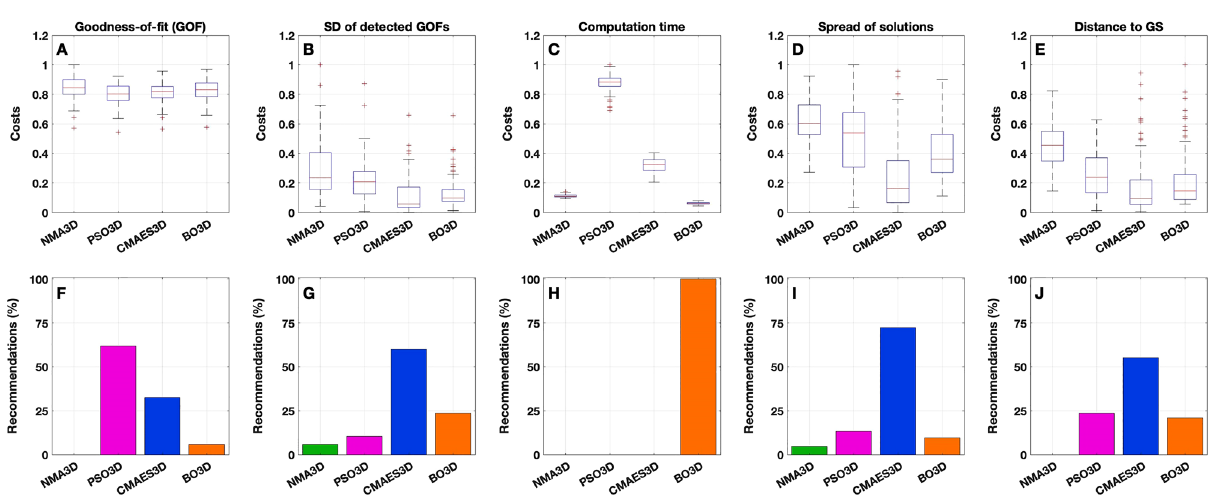
Figure 7. Components of the cost function (cid:31) cost for the 3Dim case. As in Fig. 6, ( A – E ) boxplots illustrate the distributions of the values (normalized by the respective maxima) of the components indicated in the titles, and ( F – J ) histograms show the relative number of recommendations obtained by a given optimization algorithm (NMA3D, PSO3D, CMAES3D and BO3D) for each cost component. The figure was created with MATLAB R2018a (www. mathw orks.